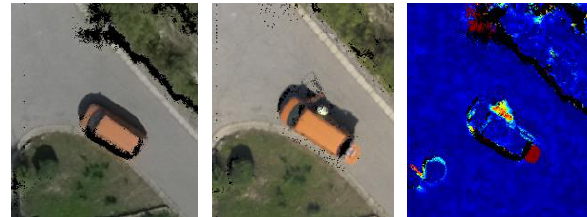
Figure 11: Textured DSM for Ricoh (left) and DigiCam (middle) with DSM differences